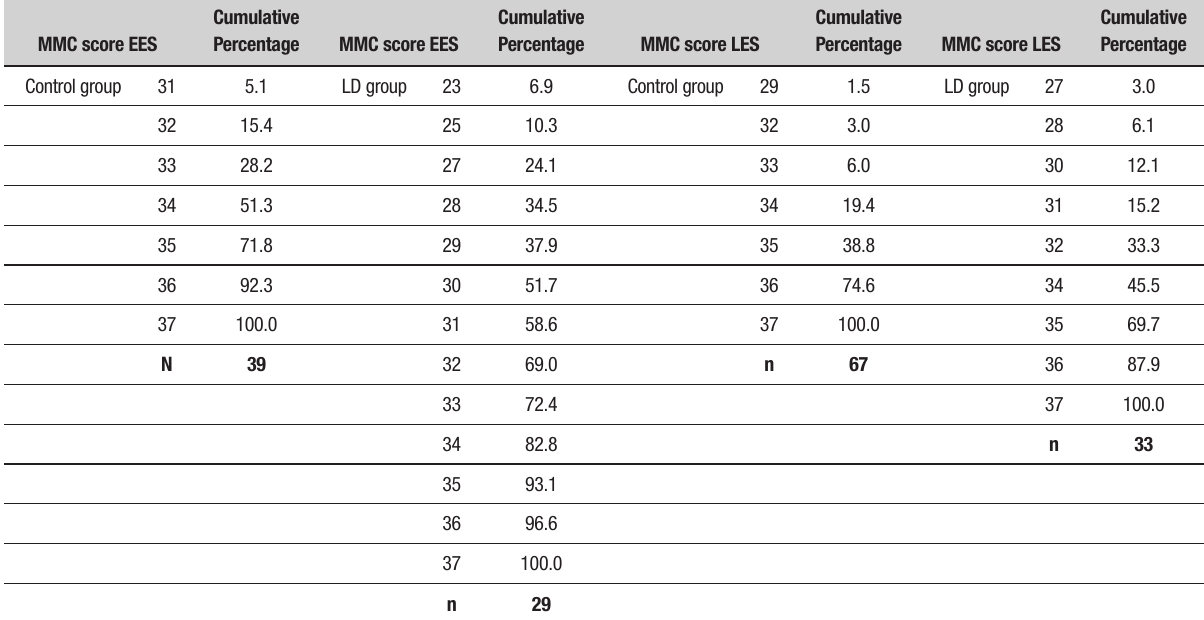
Table 2. Cumulative percentages of children according to the MMC